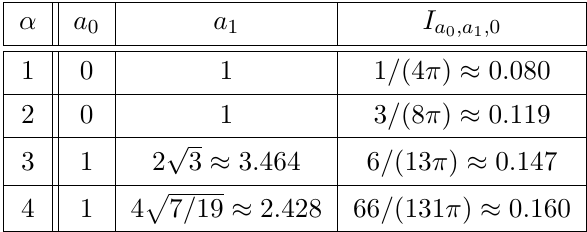
in dependence on α . Note that 0 ,a 1 ,a 2 =0